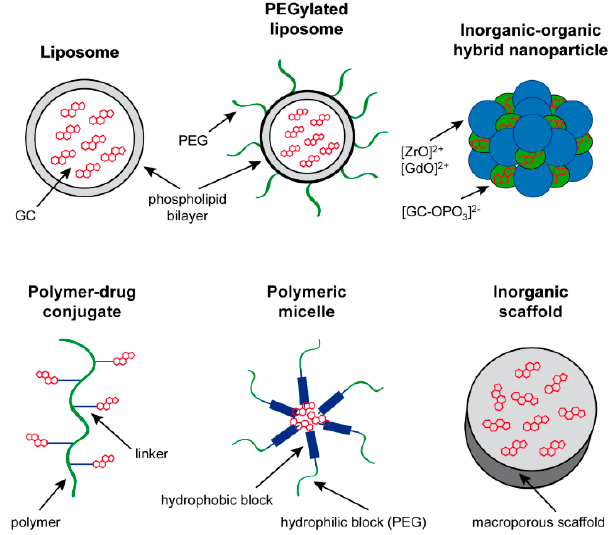
Figure 1. Current material concepts for GC delivery. Liposomes are vesicles composed of a phospholipid bilayer that are able to carry GC in their lumen. Modification of their surface by polyethylene glycol (PEG) results in the generation of so-called PEGylated liposomes with improved characteristics. GC are mostly encapsulated in the liposomal cavity in the form of their hydrophilic phosphate or acetate derivatives. In a polymer-drug conjugate, the GC is covalently bound to a macromolecular carrier via a linker, whereas polymeric micelles are spherical structures consisting of a hydrophilic block that can be PEG and a central hydrophobic block where the GC are contained. Besides organic vehicles, there are also inorganic material concepts such as large scaffolds to which GC can be adsorbed. Inorganic-organic hybrid nanoparticles are a new development which is composed of an inorganic cation, e.g., [ZrO] 2+ or [GdO] 2+ , and a functional organic anion such as a phosphorylated GC with the composition [GC-OPO 3 ] 2 − , both of which assemble into particles in a similar manner as sodium